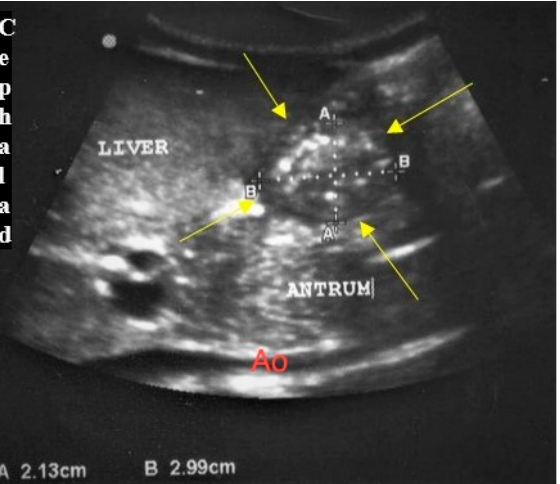
Figure 1. Gastric antrum filled with fluid; A: anteroposterior dimension; Ao: aorta; B: craniocaudal dimension.